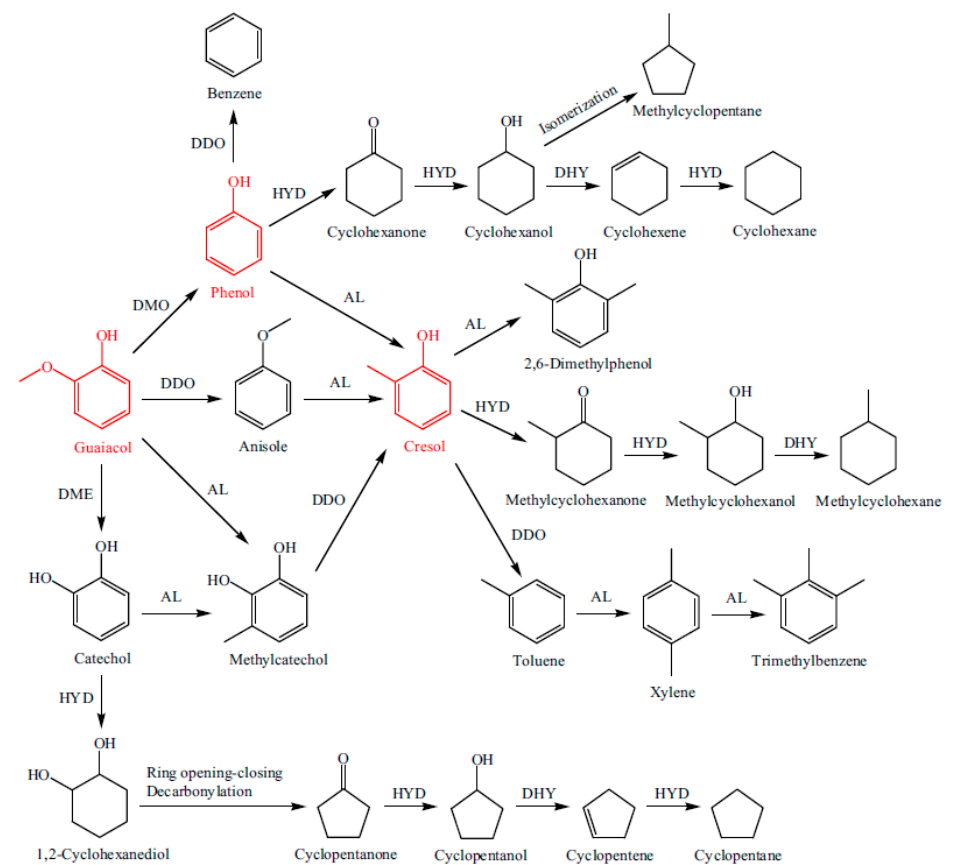
Figure 17. Proposed reaction scheme for the HDO of simulated bio ‐ oil containing guaiacol, phenol and o ‐ cresol as feedstock over Ni ‐ H ‐ Beta catalyst. Notations: DDO: direct deoxygenation, HYD: hydrogenation, DMO: demethoxylation, DME: demethylation, AL: alkylation and DHY: dehydration [40].